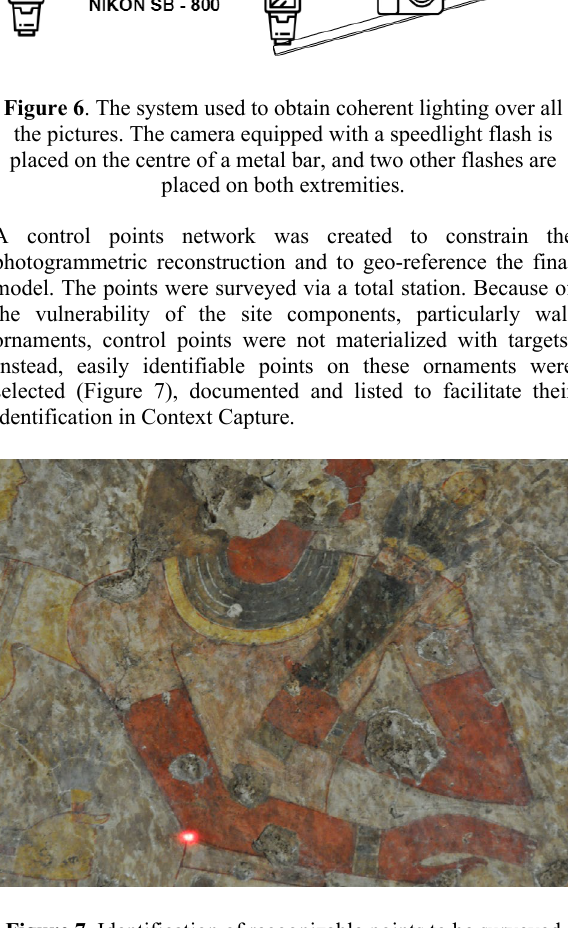
Figure 7 . Identification of recognizable points to be surveyed and used as control points.